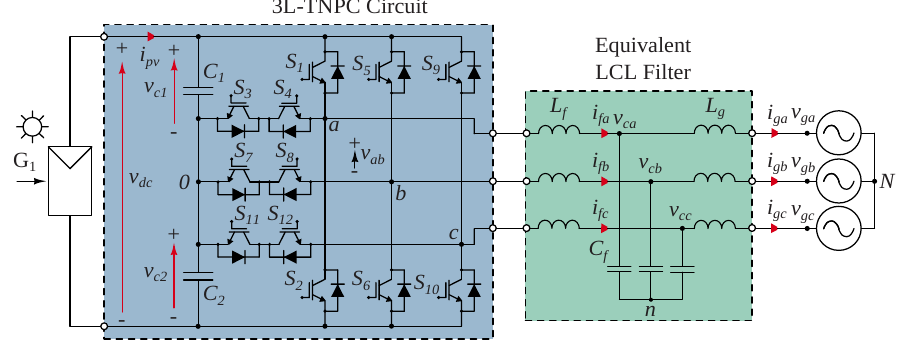
Figure 2. 3L-TNPC converter power unit.